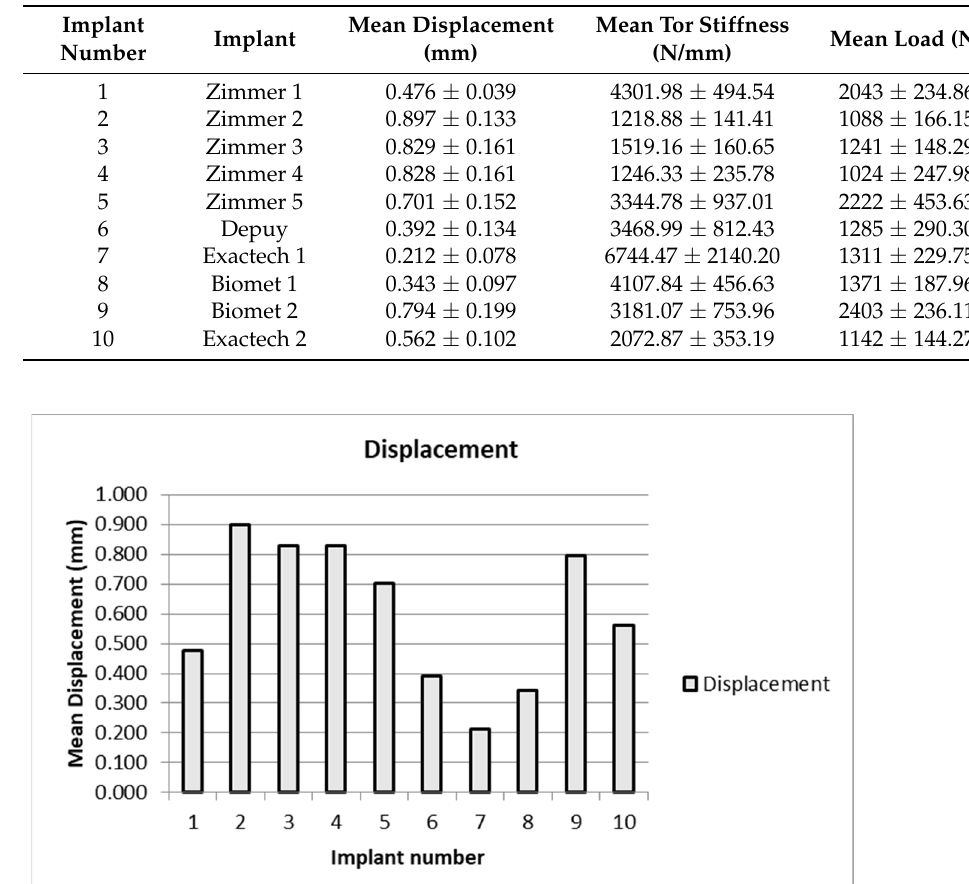
Figure 3. Mean displacement of each implant.